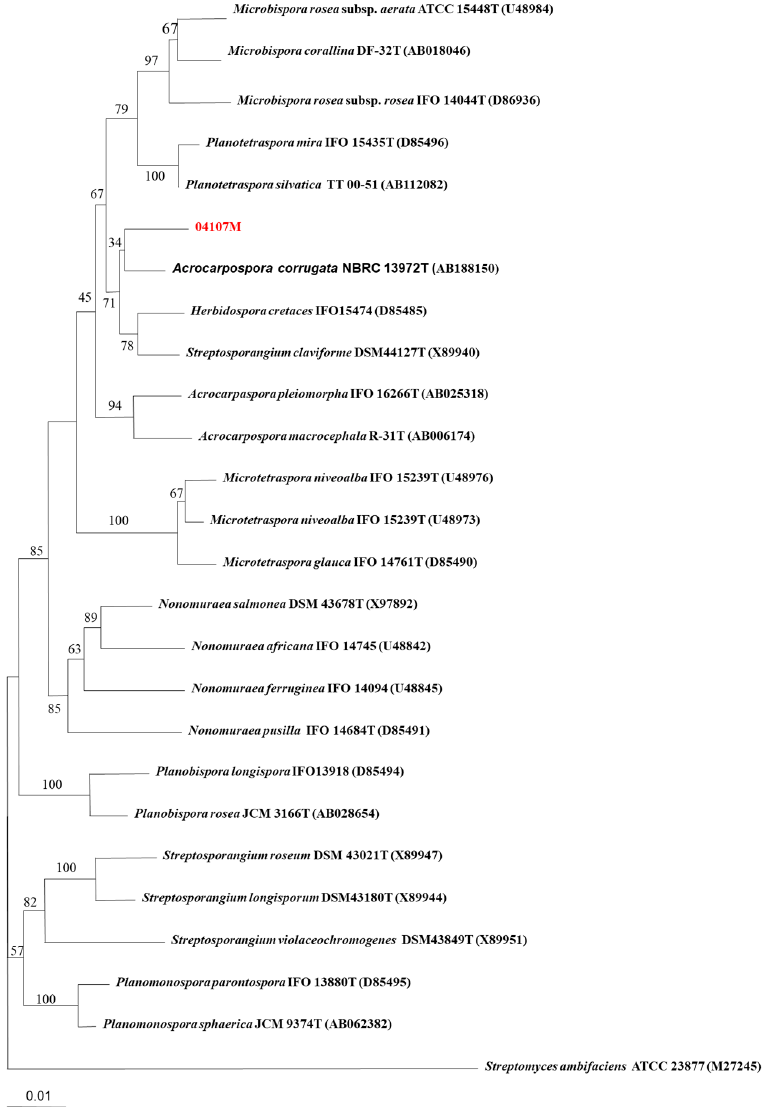
Figure 1. Neighbor-joining tree based on nearly complete 16S rDNA sequences showing the phylogenetic position of strain 04107M within the Acrocarpospora species. Numbers at the nodes indicate the percentage of 1000 bootstrap resampling procedures and only values over 50% are given. Bar: 0.01 substitutions per nucleotide